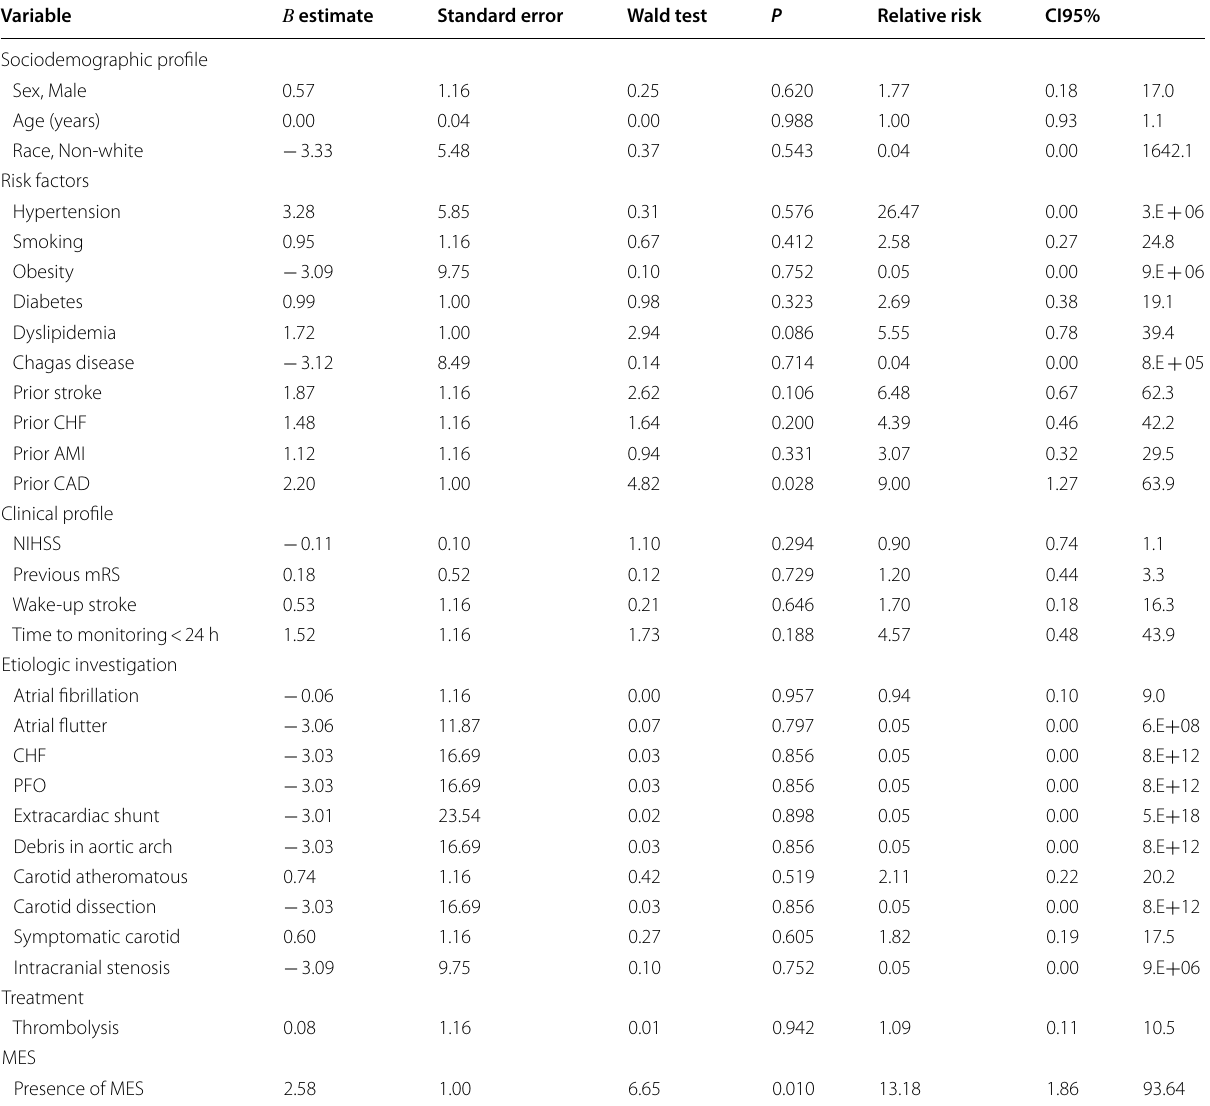
Table 4 Simple regression models of Cox adjusted to the incidence rate of stroke recurrence due to each independent